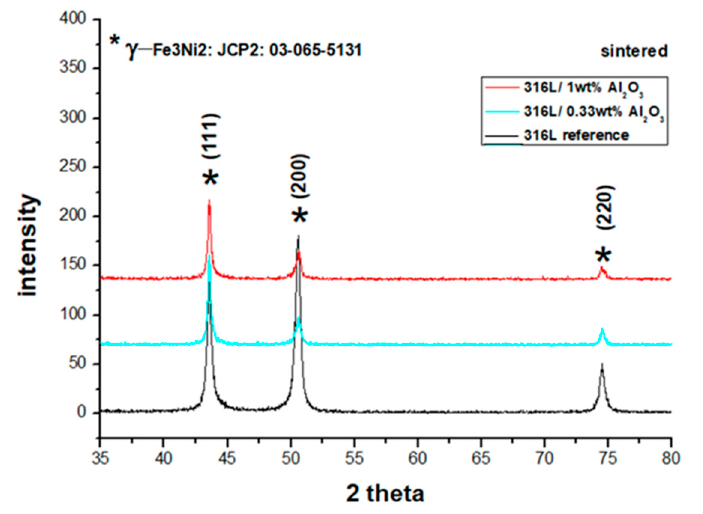
Figure 7. XRD diffractograms of the sintered composites: the reference 316L, the 316L/0.33 wt% Al 2 O 3 and the 316L/1 wt% Al 2 O 3 .